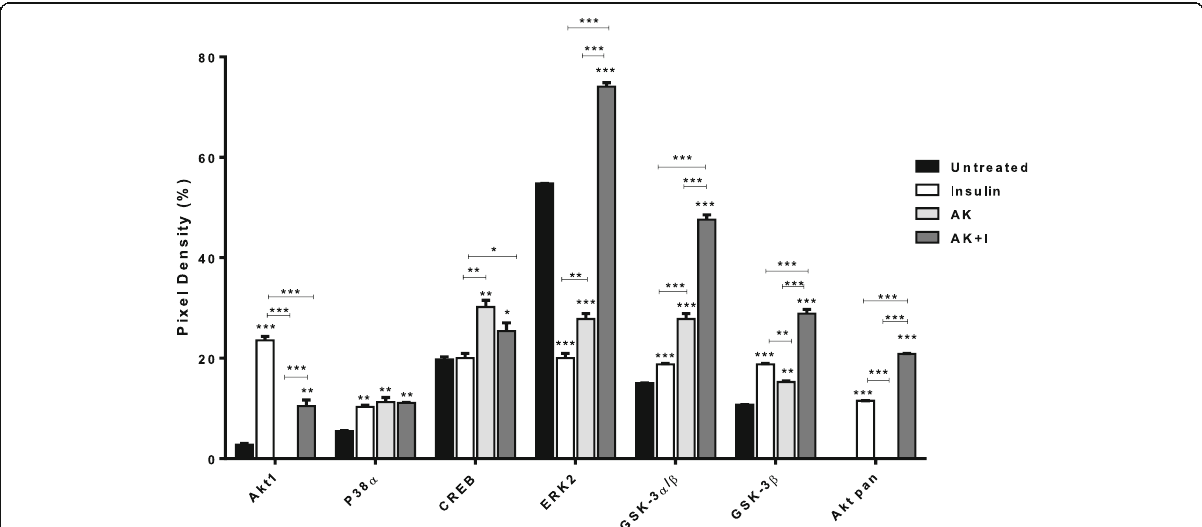
Fig. 3 The C2C12 muscle cells were either untreated or treated with insulin (3000 mIU/ml), defatted extract of A. karroo (25 μ g/ml) and a combination of the plant extract and insulin for 3 h. Data shown are from a four minute exposure to X-ray. The results obtained were expressed as means ± SEM. The statistical significance of the results was tested using one way ANOVA employing the Tukey-Kramer Multiple Comparisons Test. The P value significance was represented by an asterisk (*) for P < 0.05, two asterisks (**) for P < 0.01 and three asterisks (***) for P <